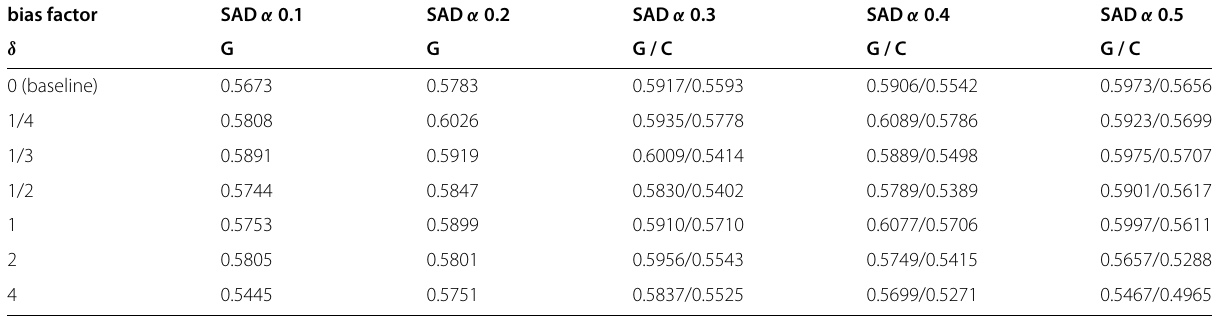
Table 9 A comparison of using different bias factors and SAD dilation-erosion factors on ASR Model 2. ATWV values are evaluated on the SAD segmented dev dataset. “G” and “C” represent GMM-HMM aligner and CTC aligner,